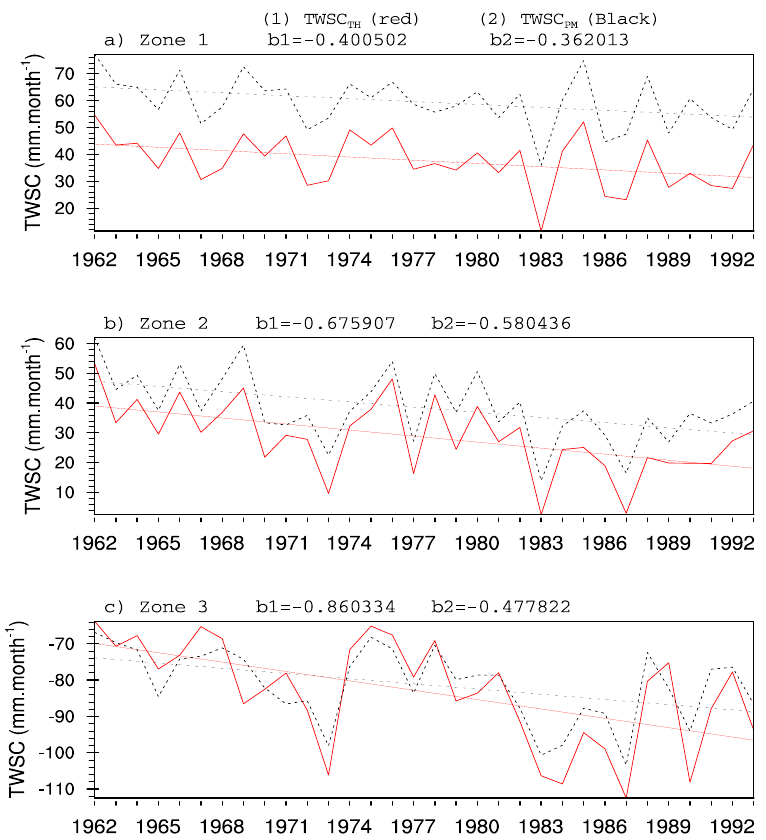
Figure 8. Time series of mean monthly TWSC (expressed in mm · month − 1 ), calculated using PET obtained from the Thornthwaite and Penman–Monteith methods: ( a ) for the Equatorial forest zone named Zone 1 (south of study area); ( b ) for the transition zone between the Equatorial forest zone and the Sahel zone named Zone 2; and ( c ) for the Sahelian zone named Zone 3 (north of study area). The regression lines are shaded and trend coefficients indicated by b1 and b2 for TWSC TH and TWSC PM ,